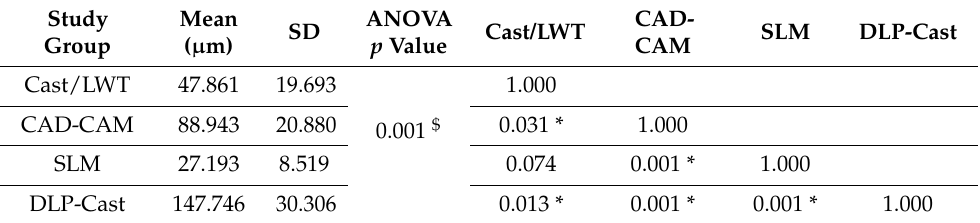
Table 2. Comparison of marginal misfit of the CoCr copings.